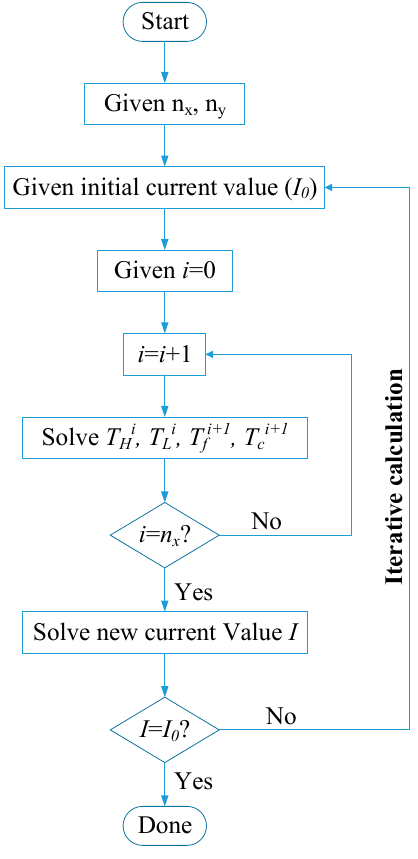
Figure 2. Flow chart of iterative calculation.